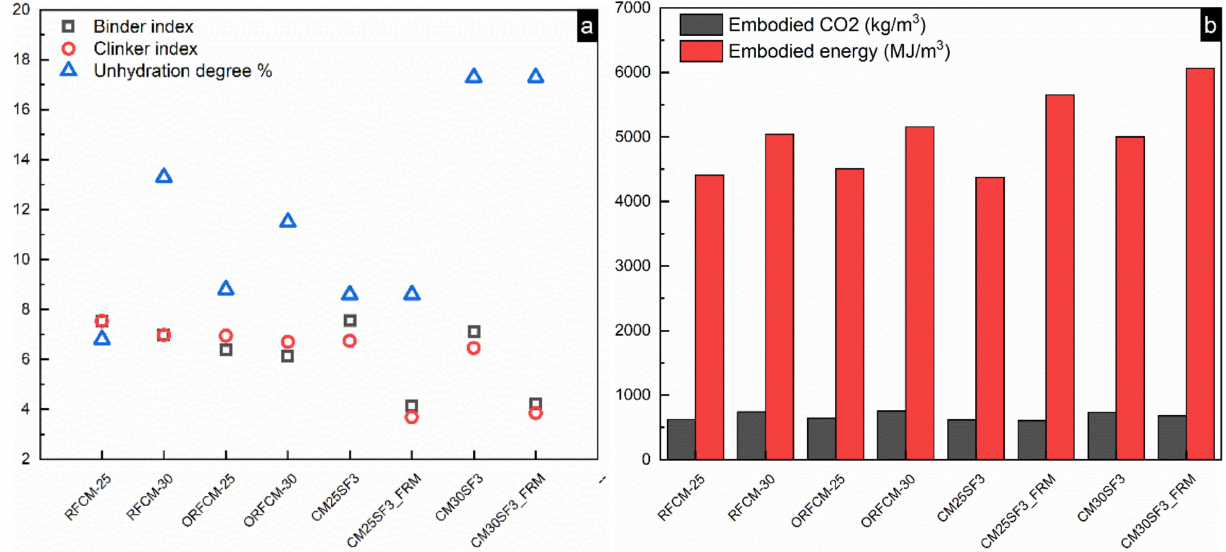
Figure 16. Comparison of environmental impact including unhydration degree, binder, and clinker index ( a ) and embodied energy and CO 2 ( b ) within reverse filling